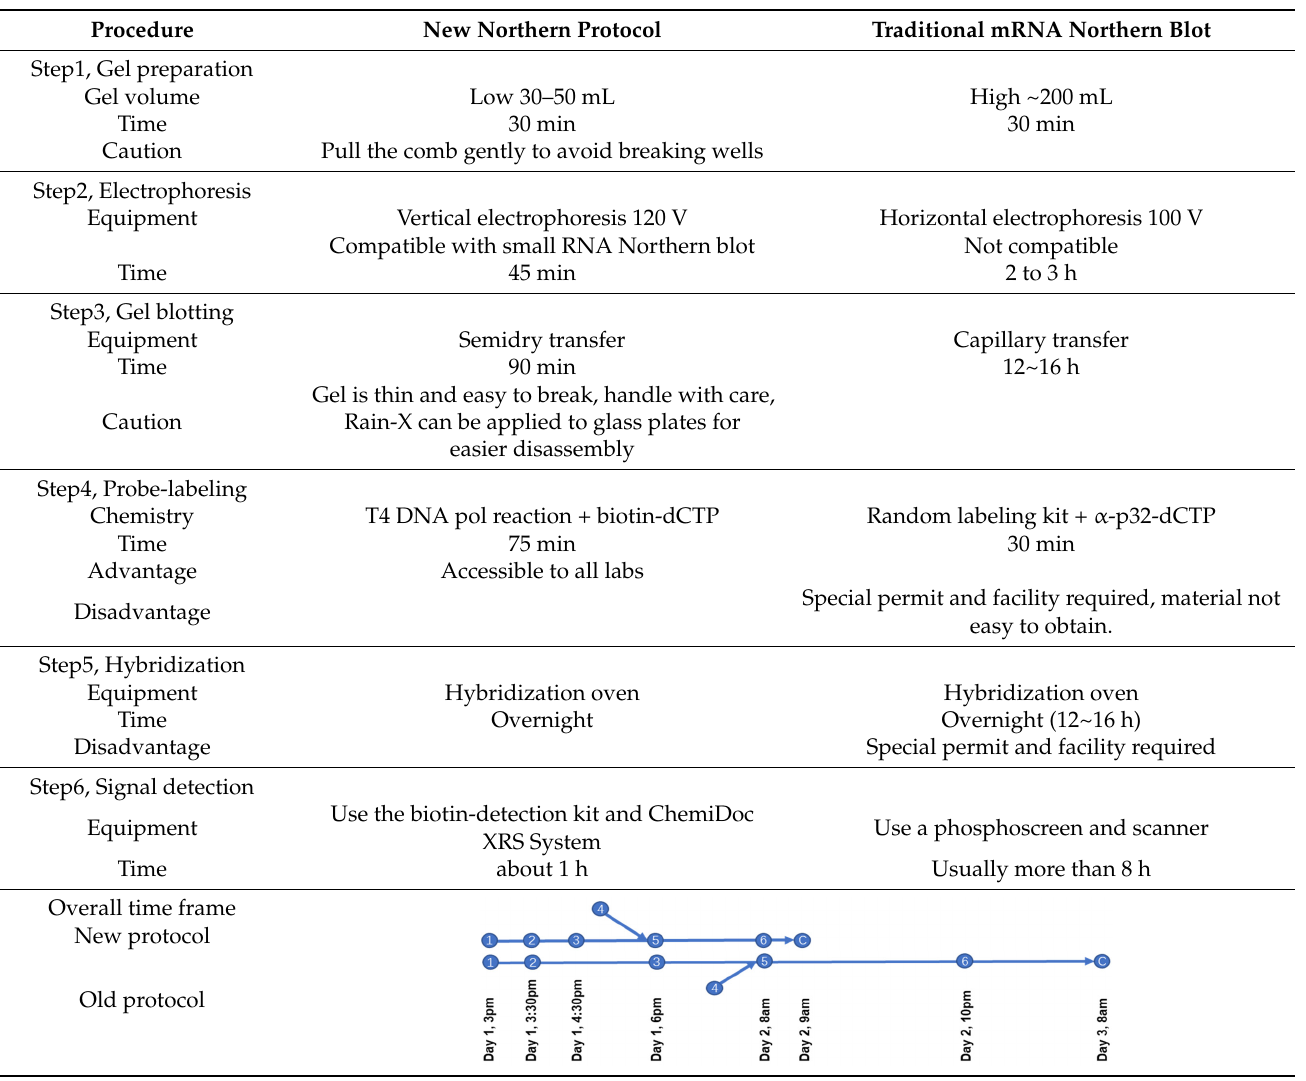
Table 1. Comparison between new Northern blot protocol and traditional Northern blot